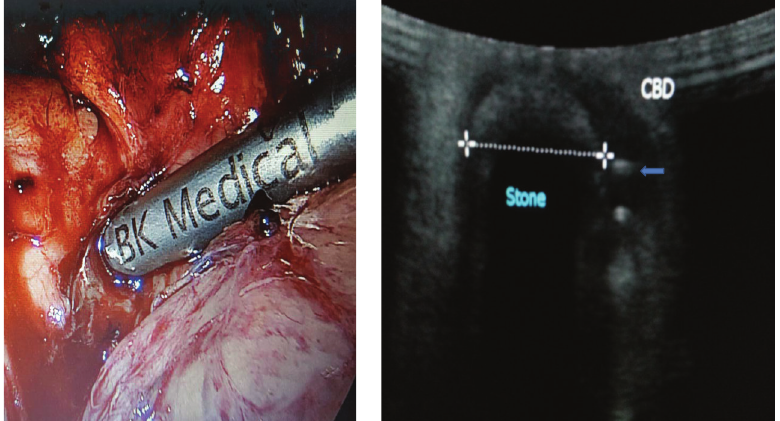
Figure 4: Laparoscopic ultrasonography probe utilized to determine location of remnant cystic duct stone and common bile duct stent (blue